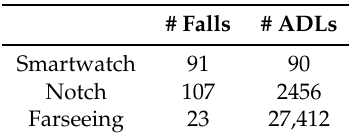
Table 1. Number of falls and ADL’s by